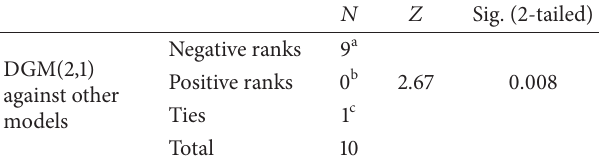
Table 7: Wilcoxon test